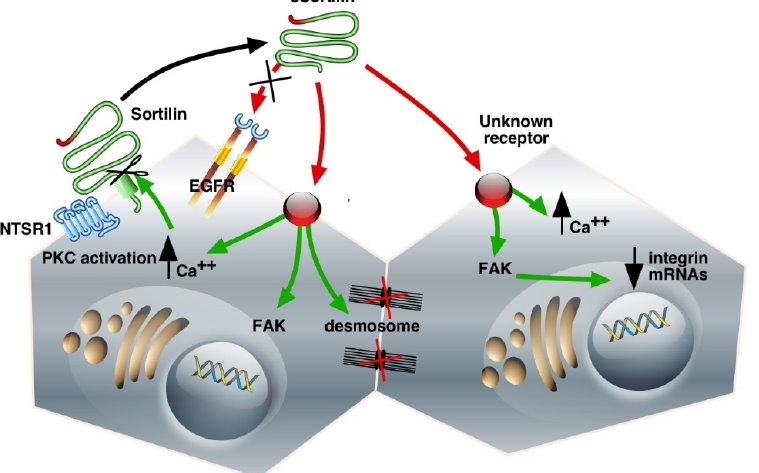
Figure 2. Schematic representation of Sortilin/NTSR3 shedding and signaling cascades in the HT29 cell line. The interaction of the membrane-bound Sortilin/NTSR3 with NTSR1 leads to the modulation of NTS-induced PKC activation. The shedding of Sortilin/NTSR3 releases sSortilin, which can interact with unknown receptors to increase intracellular Ca++, activate FAK, decrease integrin mRNAs, and lead to desmosome disruption. Green, intracellular signaling pathways; red, extracellular interactions. The abbreviations used are: NTSR1, neurotensin receptor ‐ 1; Sortilin/NTSR3, neurotensin receptor ‐ 3/sortilin; sSortilin/NTSR3, soluble neurotensin receptor ‐ 3/sortilin; EGFR, Epidermal Growth Factor Receptor; PKC, Protein Kinase C; FAK, Focal Adhesion Kinase.